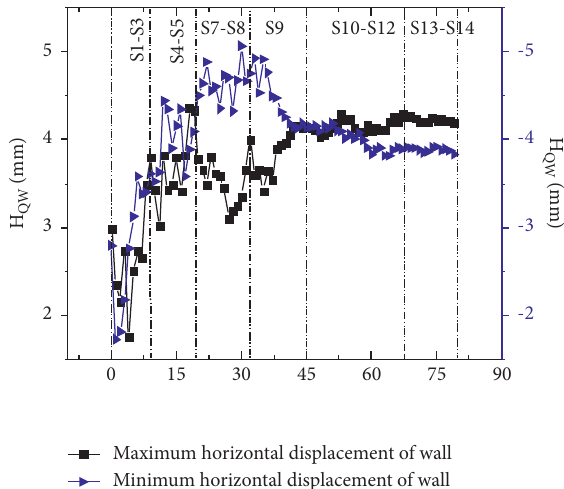
Figure 15: The cumulative curve of the displacement of the maximum and minimum deformation point of the ground con- necting wall with time.